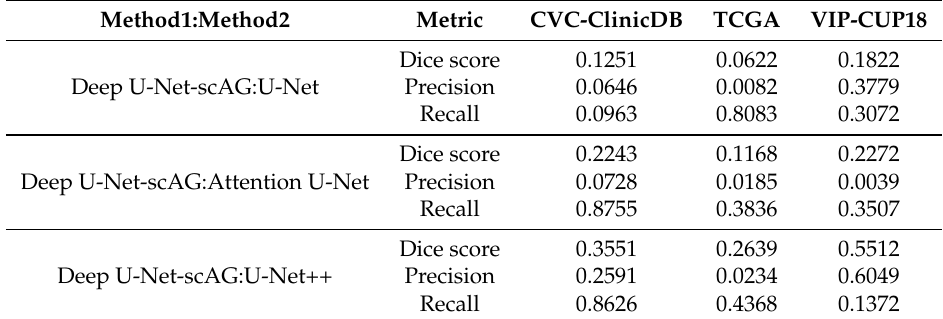
Table 9. Comparison of p -value between Deep UNet-scAG versus UNet, Attention UNet, and UNet++ based on Dice score, Precision, and Recall on the three dataset CVC-ClinicDC, TCGA and VIP-CUP18. Method1:Method2